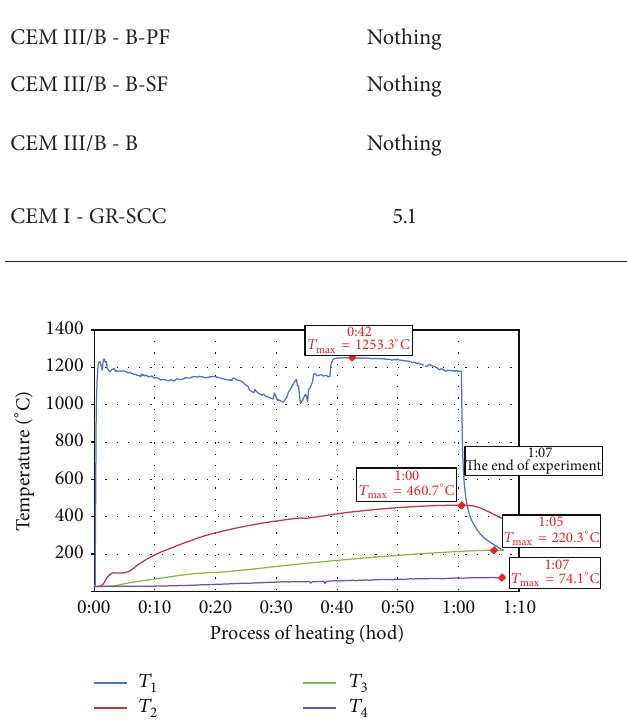
Figure 3: Record of thermal development of the test specimen CEM III/B -